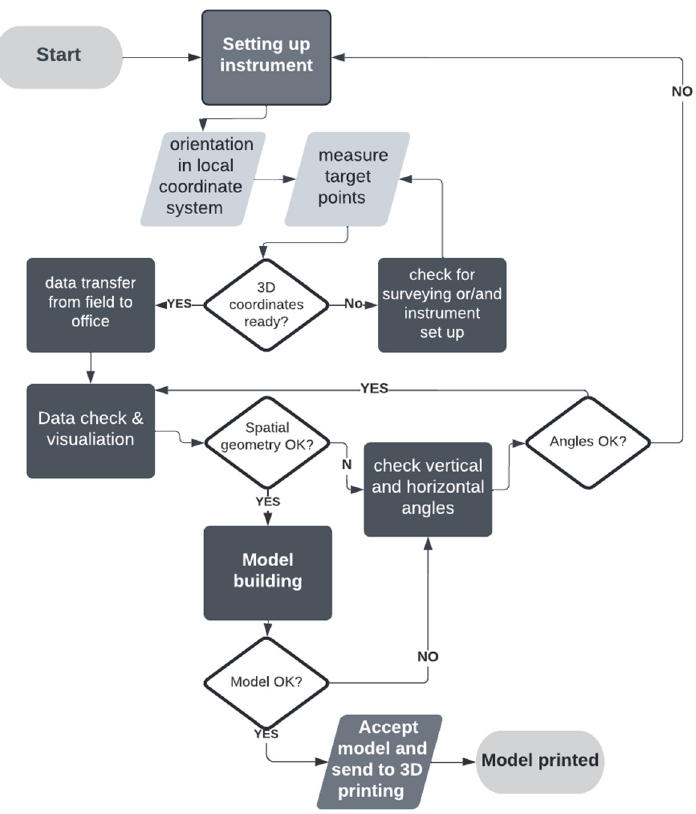
Figure 2. Diagram of the process of developing and 3D printing a prototype of a total station housing for one standpoint (created using Lucidchart).